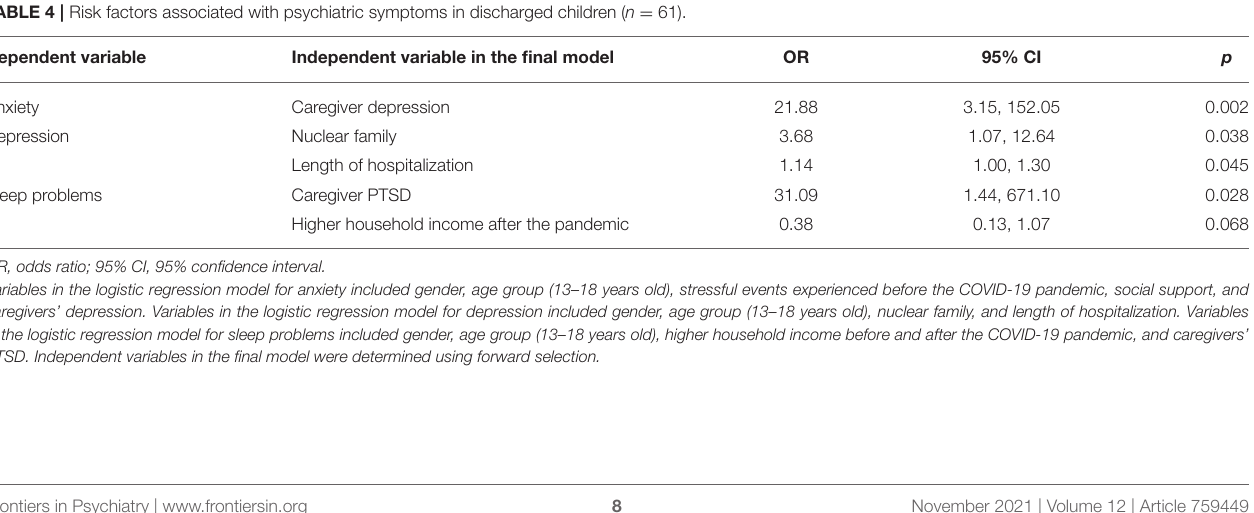
TABLE 4 | Risk factors associated with psychiatric symptoms in discharged children ( n = 61).